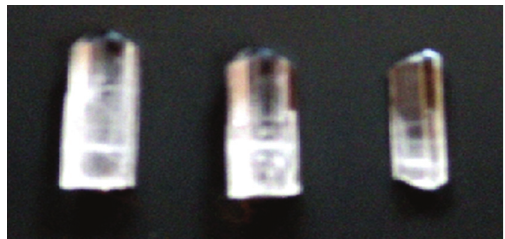
Figure 13: Deuterated L-threonine single crystals grown from seed rotation